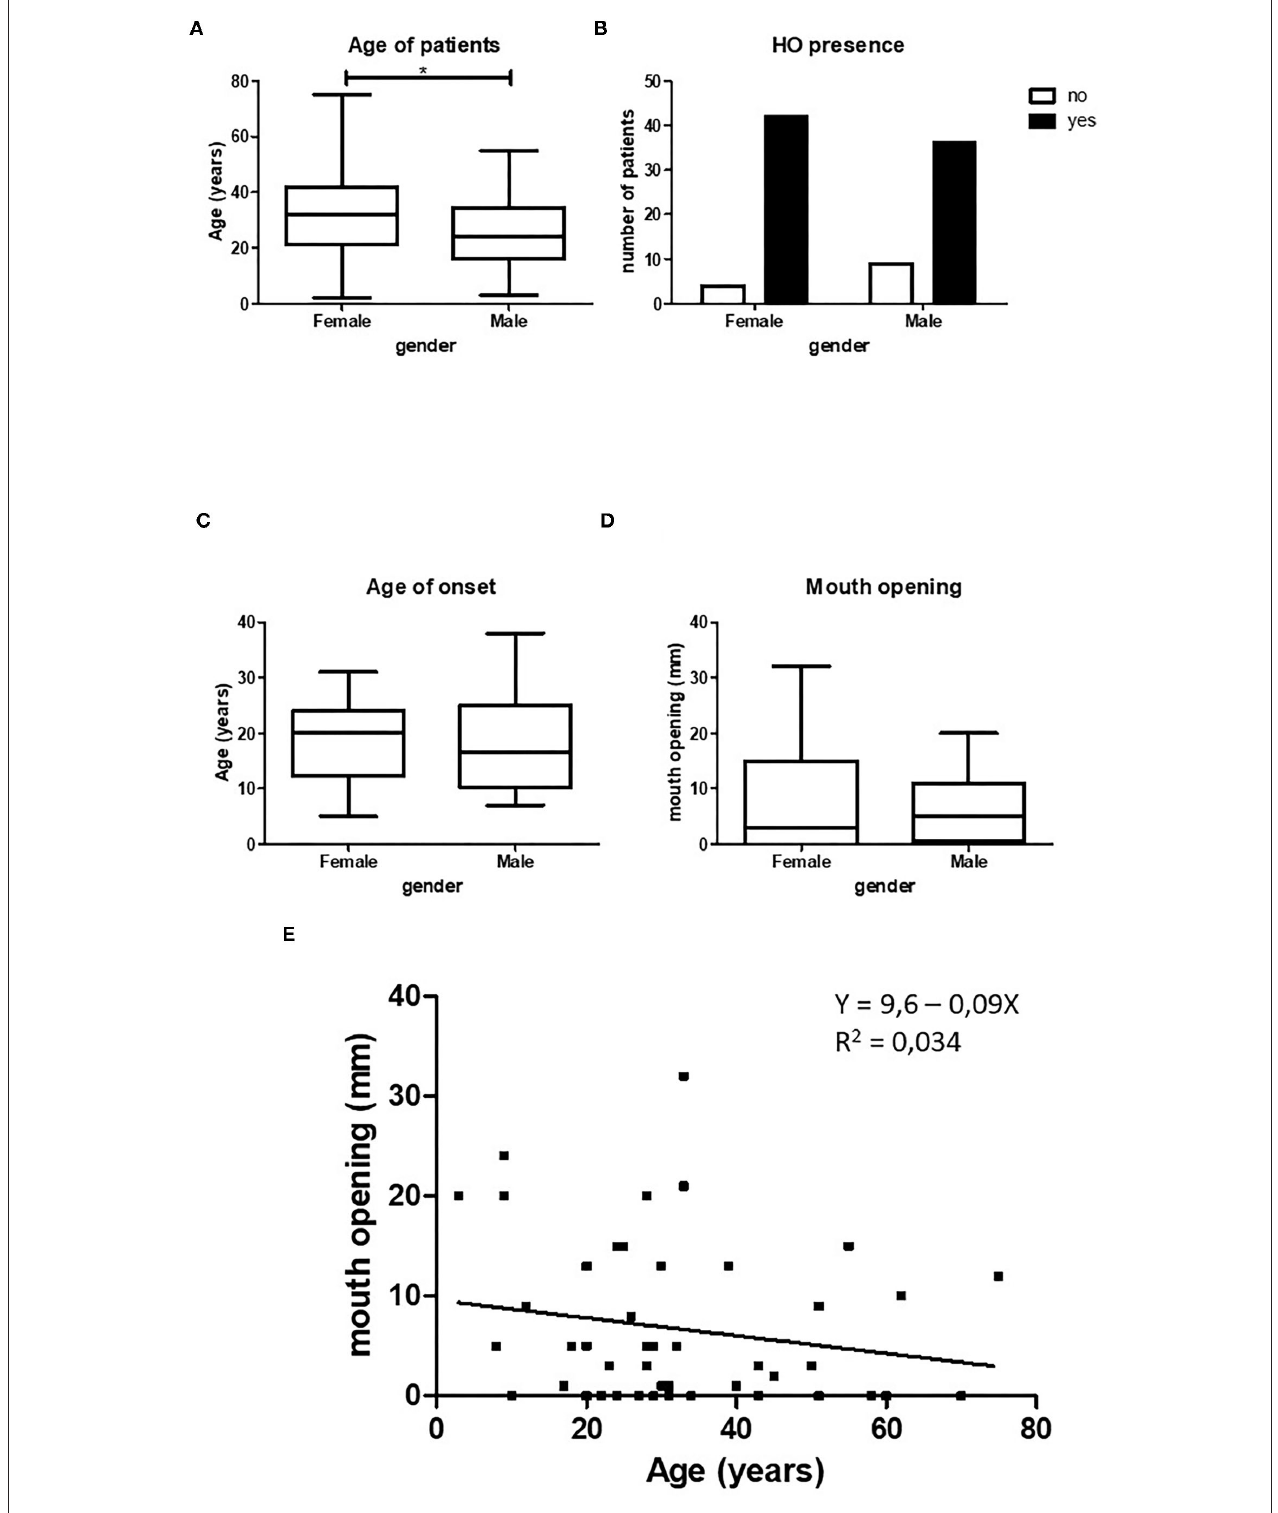
FIGURE 2 | Relation between HO and gender. Female patients in our cohort were significantly older than male patients, (A) ( p < 0.5, female n = 47, male n = 45). Female patients show statistically more HO in the maxillofacial area compared to male patients, (B) ( p < 0.05, female n = 47, male n = 45). There is no difference between age of onset of HO ( C , female n = 34, male n = 24) or between mouth opening ( D , female n = 23, male n = 25) and gender. When both female and male patients are taken together there is a non-significant decrease in maximum mouth opening with increasing age ( E , n = 48). * p < 0.05.